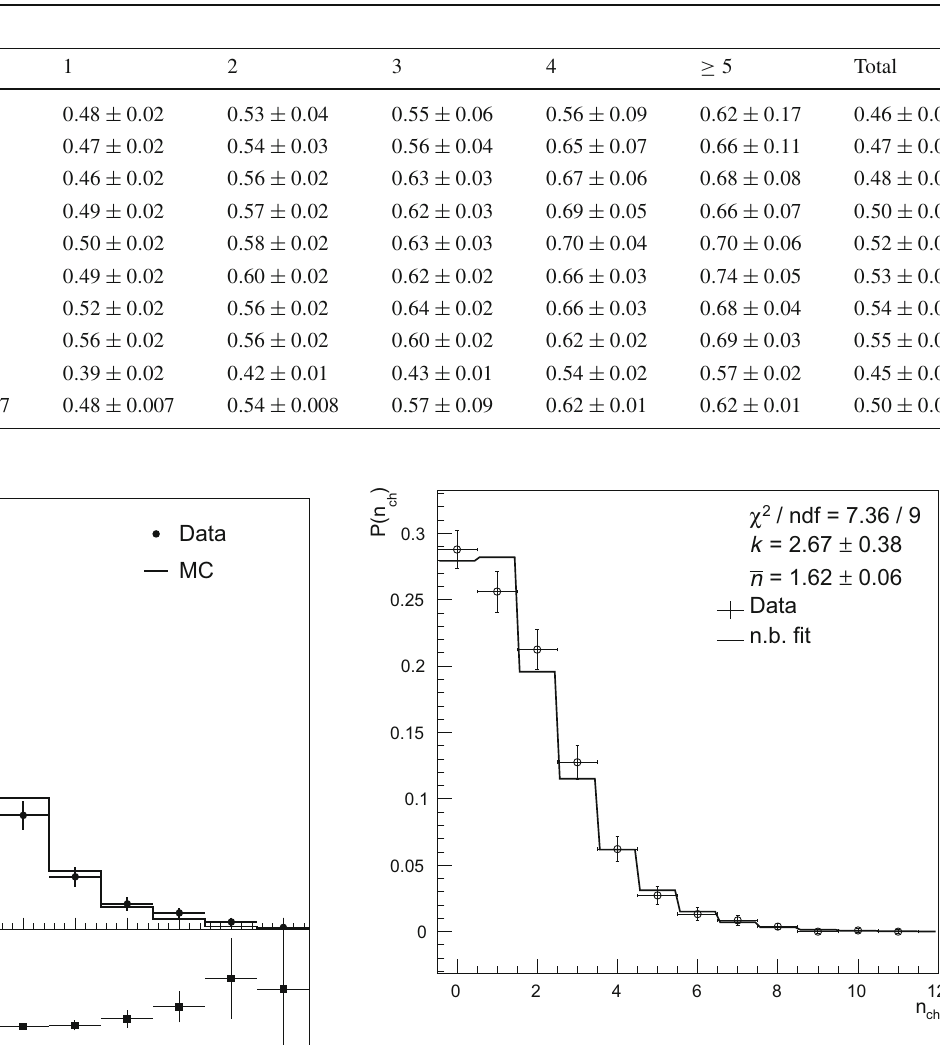
Fig. 7 The multiplicity distribution corrected for efficiencies super- imposed with the negative binomial distribution (n.b.) defined in Eq. 1 where E ν and E μ are the energy of the incoming neutrino and the muon, Q 2 ν the squared four-momentum transfer, m N and m μ are the mass of the nucleon and muon respectively. The average neutrino energy of the data sample is (cid:3) E ν (cid:4) = ( 19 . 6 ± 0 . 3 ) GeV, the mean-square momentum transferred to the hadronic system is (cid:3) Q 2 ν (cid:4) = ( 5 . 7 ± 0 . 3 ) GeV 2 / c 2 , and the mean-square of the invariant mass of the hadronic system is (cid:3) W 2 (cid:4) = ( 16 . 9 ± 0 . 6 ) GeV 2 / c 4